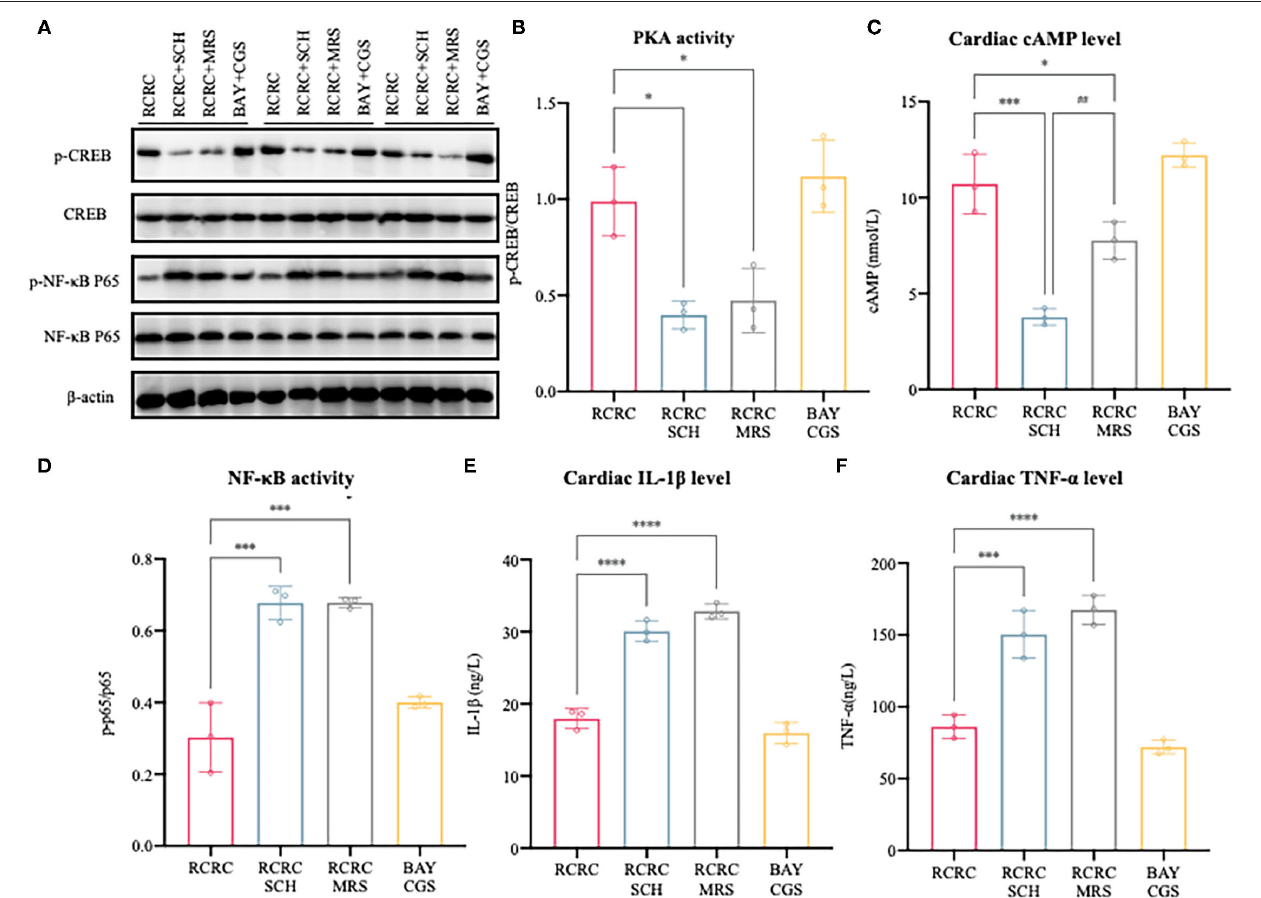
FIGURE 7 | Activation/inhibition of A2 receptors affects remote conditioning-regulated release of pro-inflammatory factor following myocardial ischemia injury. (A) Western blot was performed to determine p-CREB, CREB, p-NF- κ B p65, and NF- κ B p65. (B) Quantitative analysis of p-CREB and CREB expression and calculate the ratio of p-CREB/CREB, N = 3. (C) Levels of cAMP in the heart of AMI rat were determined by ELISA, N = 3. (D) Quantitative analysis of p-NF- κ B p65 and NF- κ B p65 expression and calculate the ratio of p-p65/p65, N = 3. (E,F) The concentrations of IL-1 β and TNF- α in the heart were determined by ELISA, N = 3. * p < 0.05, *** p < 0.001 vs. RCRC; ## p < 0.01 vs. RCRC + SCH, **** p <